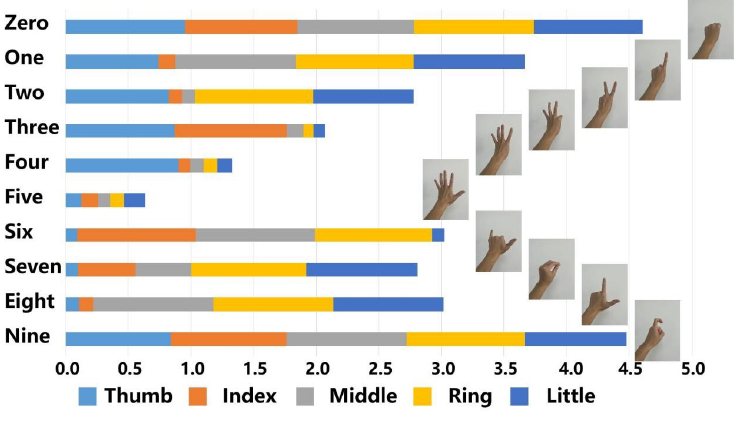
Figure 4. The average measurements of the